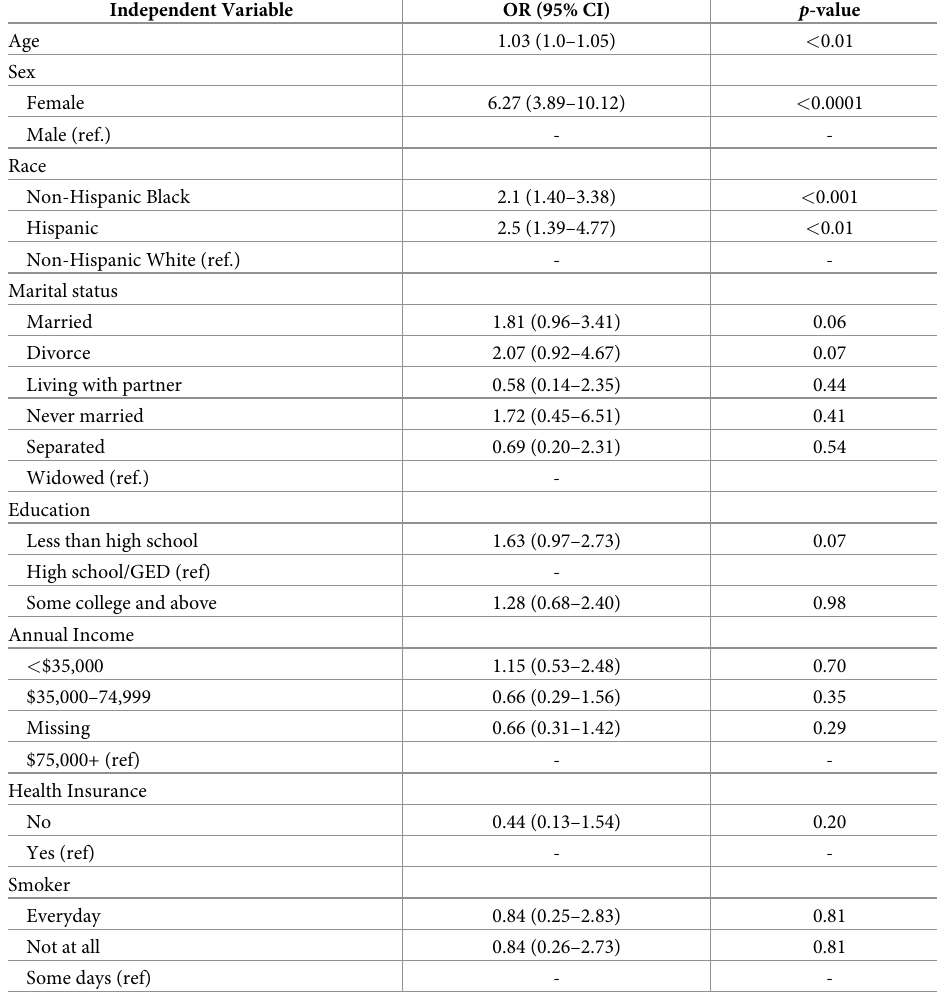
Table 2. Multivariable logistic regression analysis of obesity-related cancers in adults with metabolic syndrome, National Health and Nutrition Examination Survey